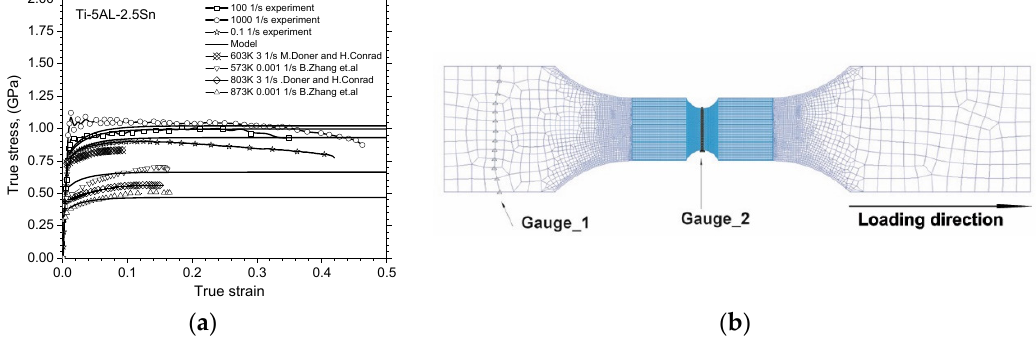
Figure 12. ( a ) Calculated stress versus strain and experimental true stress vs true strain curves of Ti ‐ 5Al ‐ 2.5Sn and ( b ) mesh model of specimen with notch.